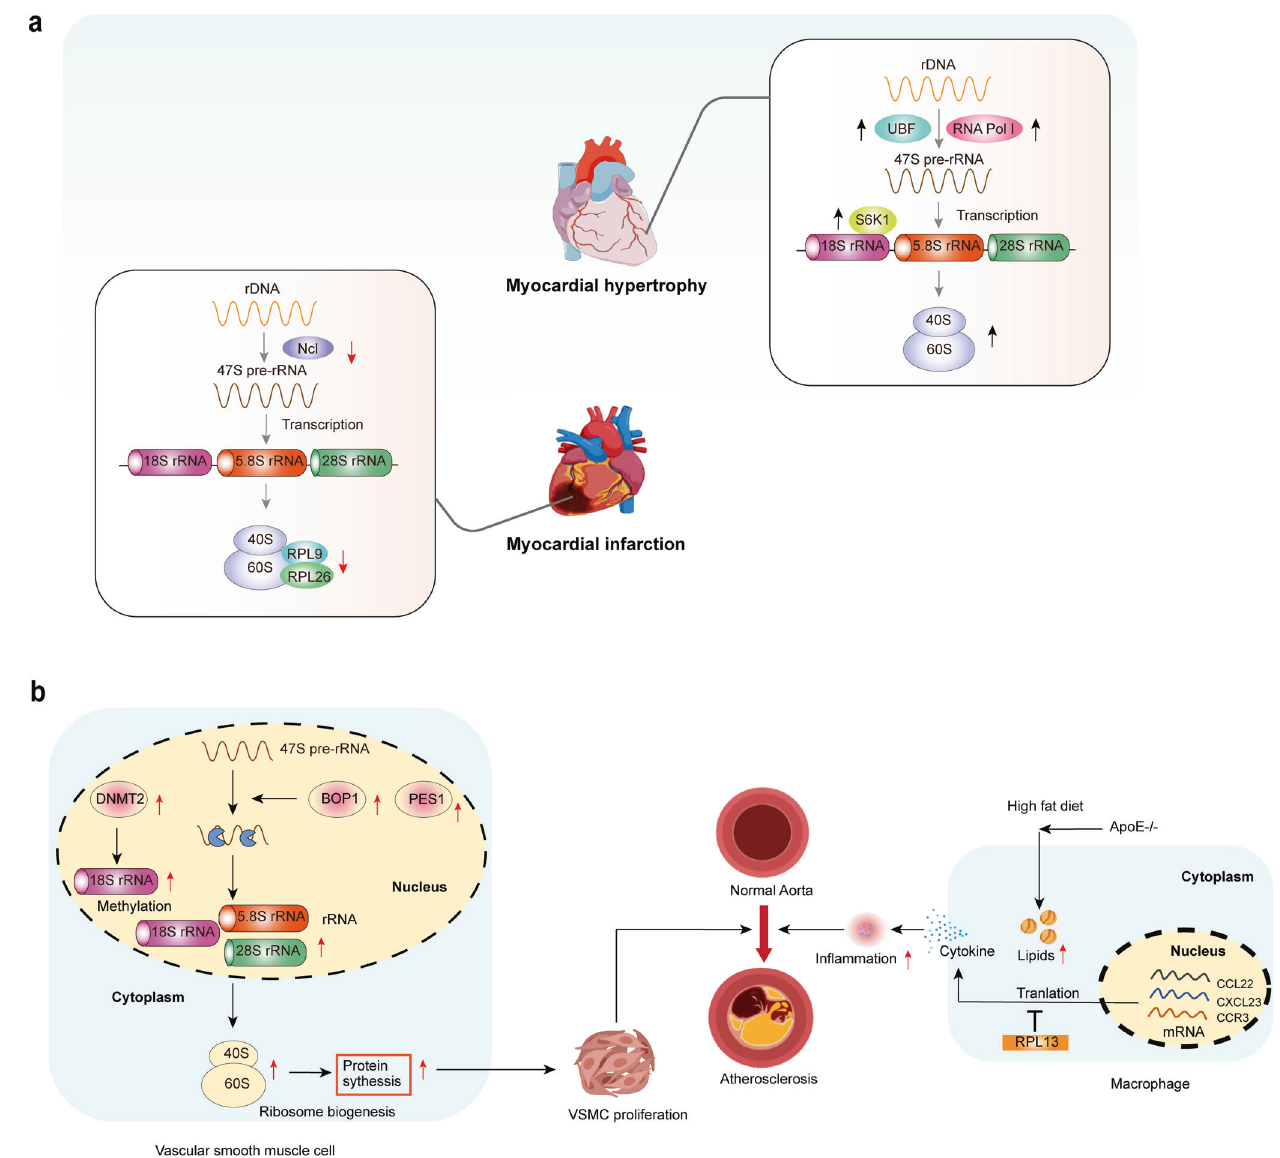
Fig. 6 Ribosomes and CVD. a (i) Ribosome dysfunction and cardiac hypertrophy. Increased UBF activity and abnormal activation of RNA Pol I and S6K1 induce cardiac hypertrophy. (ii) Ribosome dysfunction and MI. Downregulation of Ncl, rRNA, RPL9, and RPL26 leads to the failure of pre-rRNA processing, ultimately causing ribosome dysfunction and MI. b Ribosomes and atherosclerosis. Left: The over-activation of ribosome biogenesis results in abnormal proliferation of VSMCs and atherosclerosis. The expression of BOP1 and PES1 is increased in atherosclerotic patients, and both promote rRNA maturation by promoting pre-rRNA splicing and ribosome biogenesis. Right: RPL13 inhibits macrophage- induced in fl ammation and atherosclerosis. A high-fat diet promotes atherosclerosis in ApoE − / − mice, accompanied by higher levels of in fl ammatory cytokines. RPL13 inhibits the in fl ammatory response by inhibiting the translation of in fl ammatory genes such as CCL22, CXCL13a, and CCR3. BOP1 blocking of proliferation 1, PES1 pescadillo homolog 1 a key factor in regulating ribosome biogenesis and cardiomyo- immature rRNAs and a reduction of RPs. Their fi ndings revealed that cyte growth. The above studies suggest that aberrant activa- rRNA processing acts as a "bridge" to link transcription and tion of S6K1 increases protein synthesis and growth in translation by regulating ribosome assembly. In addition, RNA Pol I hypertrophic cardiomyocytes. S6K1 is an important drug target is primarily responsible for the processing of pre-47S transcripts into for the treatment of cardiac hypertrophy (Fig. 6a). Thus, 5.8S, 18S, and 28S rRNA, and then generating mature rRNAs. 15 abnormal upregulation of UBF, RNA Pol I, and S6K1 induces Studies have demonstrated that TAF1A gene mutation of RNA Pol I cardiac hypertrophy. cause gene-speci fi c nucleolar defects and impair rRNA synthesis in cardiomyocytes, eventually leading to decreased ventricular systolic function, dilated cardiomyopathy (DCM), and heart failure. 9,159,160 S6K1-dependent activation of RP synthesis is crucial for cardiomyocyte proliferation and growth. S6K1 promotes rDNA transcription in cardiomyocytes, accelerating the pathological evolution of cardiac hypertrophy. 161 This suggests that S6K1 is Signal Transduction and Targeted Therapy (2023)